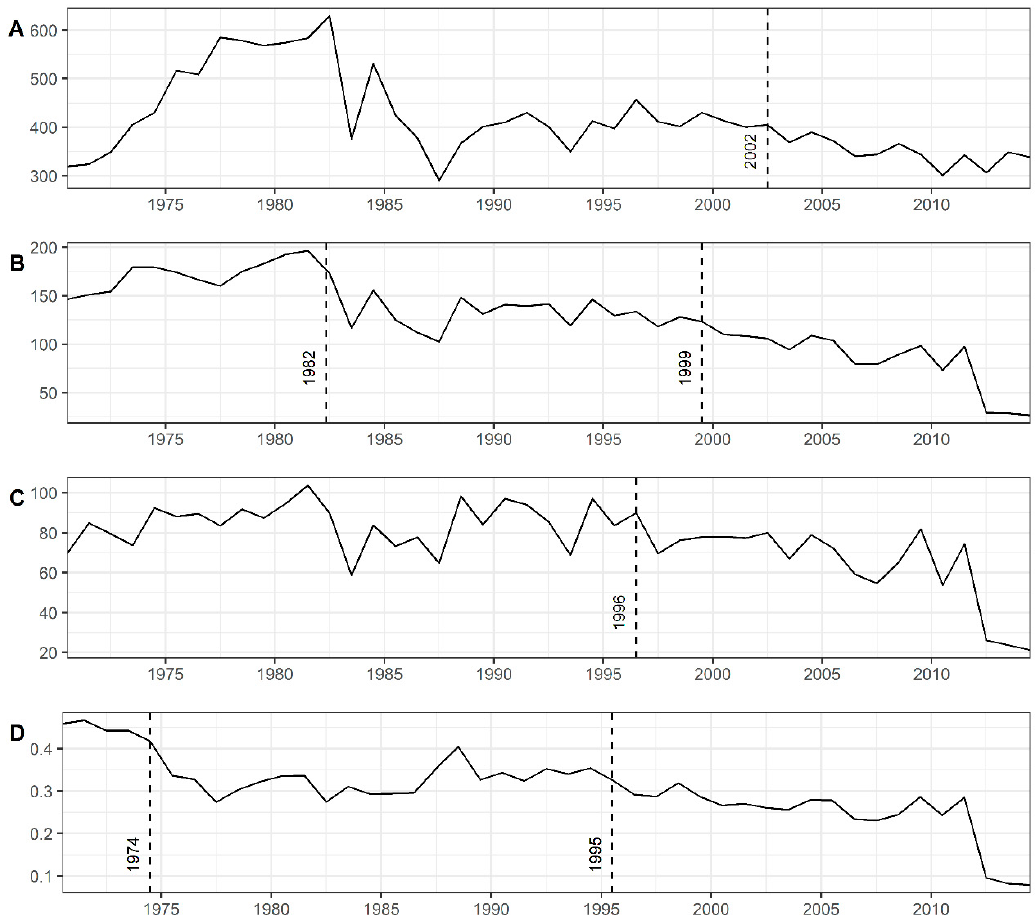
Figure 7. Change points for annual agricultural characteristics by agricultural counties from 1984 to 2014: ( A ) total annual field crop acres harvested, ( B ) rice acres harvested measured in thousands of acres harvested (000s acres), ( C ) rice production measured in thousands of hundredweights (000s cwt), and ( D ) rice proportion of total field crop acres harvested.